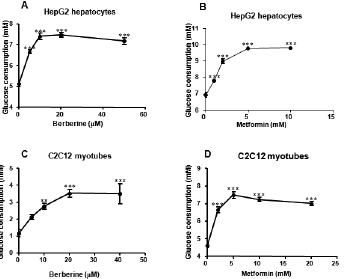
Figure 4. Berberine promoted glucose consumption in a dose- dependent manner in HepG2 hepatocytes and C2C12 myo- tubes. Cells were cultured in 96-well plates firstly. During experiments, culture medium was replaced by serum-free DMEM supplemented with 0.25% BSA and 15 mM D-glucose. Glucose consumptions were measured after 24-hour incubation with increasing concentrations of berberine or metformin. A: Effect of berberine on glucose consumption in HepG2 cells. B: Effect of metformin on glucose consumption in HepG2 cells. C: Effect of berberine on glucose consumption in C2C12 cells. D: Effect of metformin on glucose consumption in C2C12 cells. Data are expressed as means 6 SEM from at least four independent experiments. ** P , 0.01 and *** P , 0.001 vs . corresponding control (0 mol/L).